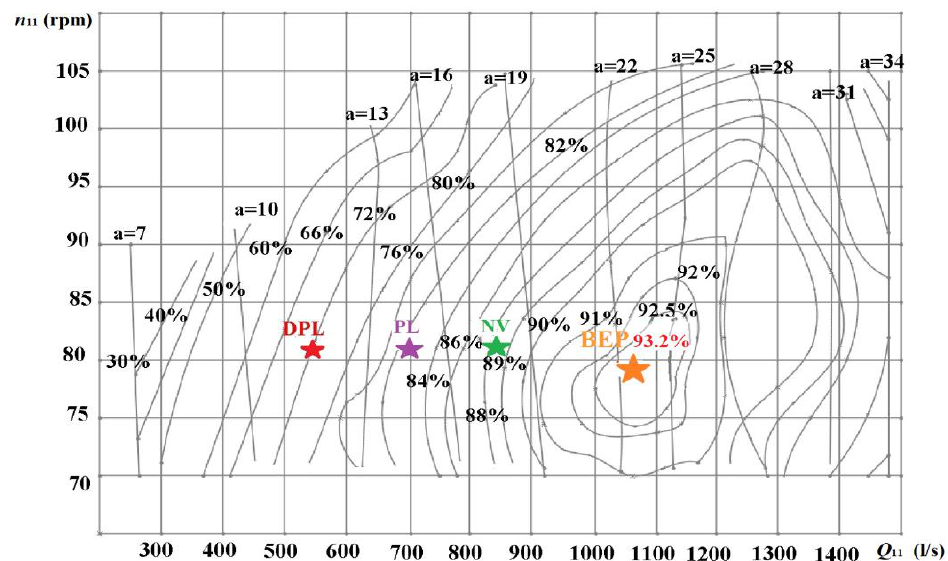
Figure 6. Comprehensive characteristic curve of HLA551 and its four experimental points.